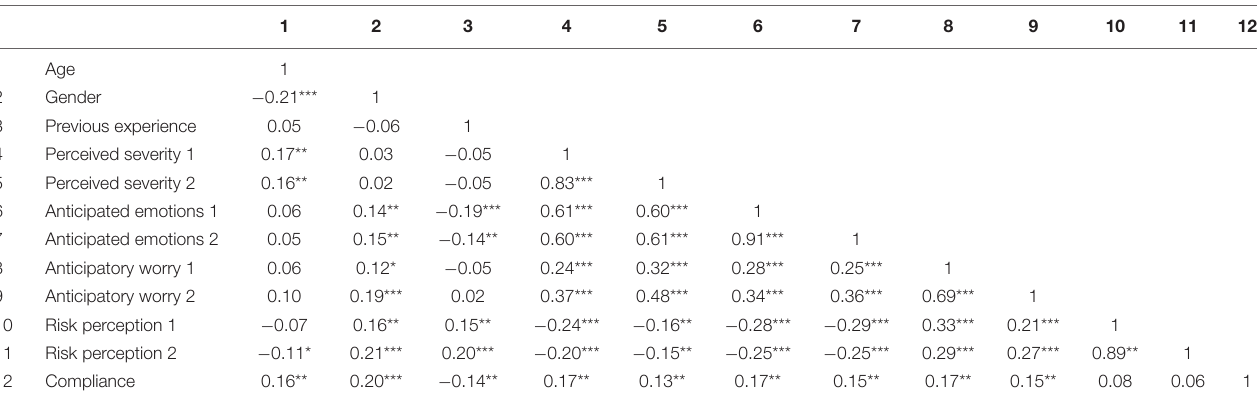
TABLE 2 | Pairwise (Pearson) correlations of age, gender, previous experience, risk appraisal before (1) and after (2) the receipt of a warning message, and the intention to comply, N =